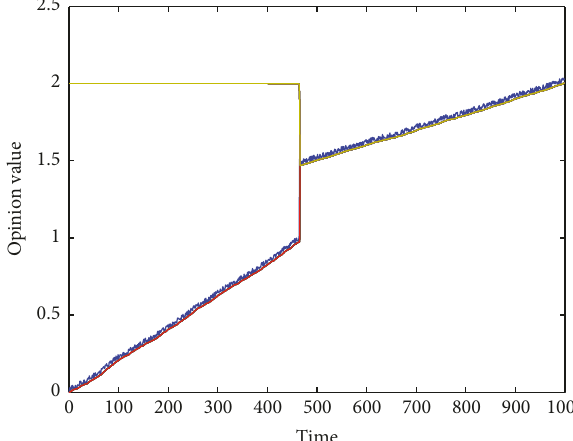
Figure 1: Opinion evolution of system (2)–(5) of 20 agents with noise uniformly distributed on [0, 0.02]𝜖 . The initial opinion value 𝑥(0) = [0 0 0 0 0 0 0 0 0 0 2 2 2 2 2 2 2 2 2 2] , confidence threshold 𝜖 = 1 , and noise strength 𝛿 = 0.02 .